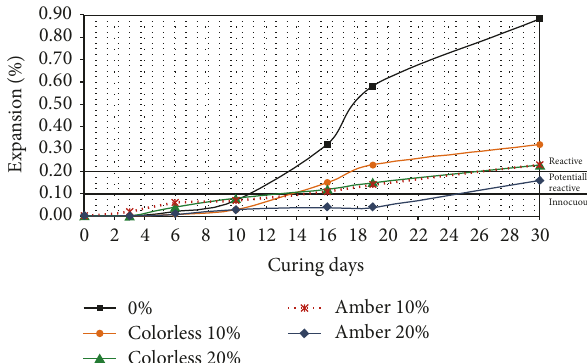
Figure 3: Accelerated carbonation test results, 60 days.